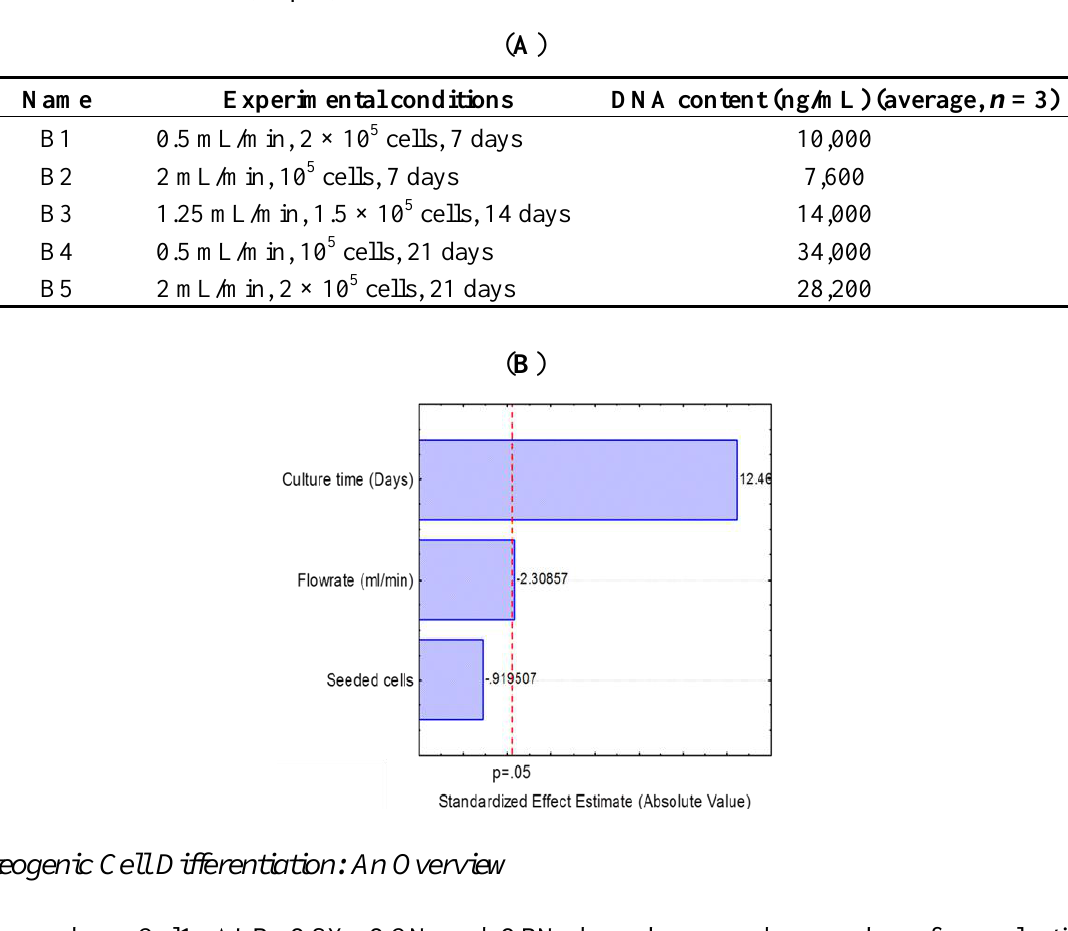
Table 1. ( A ) DNA content after perfusion bioreactor culture for all experimental conditions; ( B ) Pareto chart showing levels of significance of process parameters (inputs) on final DNA content (output) of in vitro cultured TE